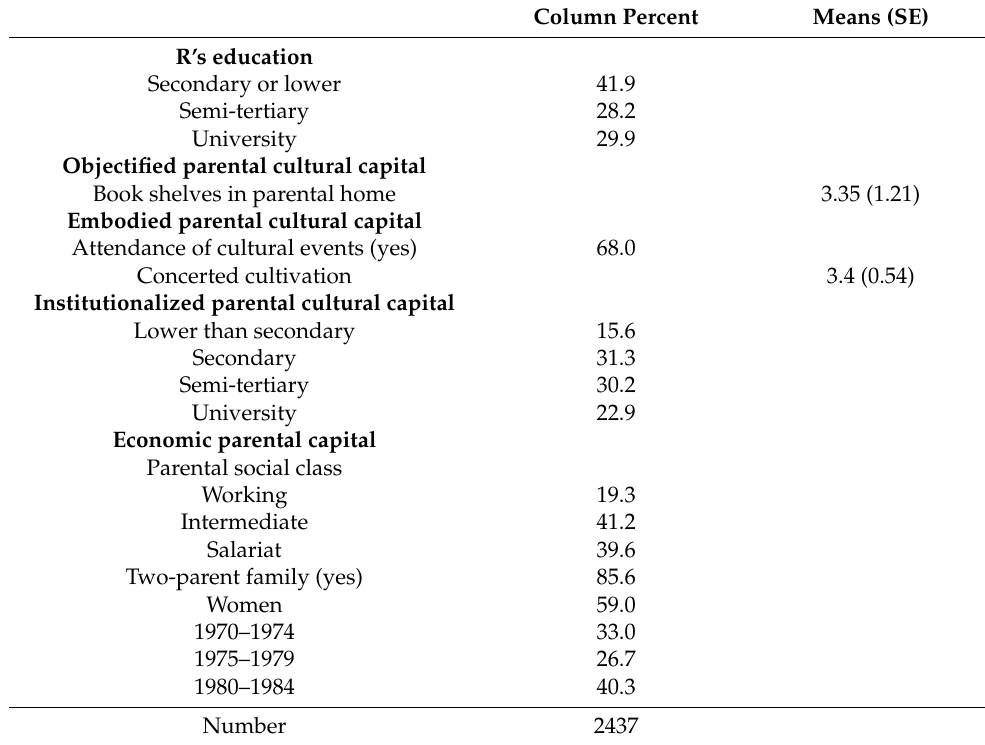
Table 1. Descriptive sample statistics, percentage and means (standard